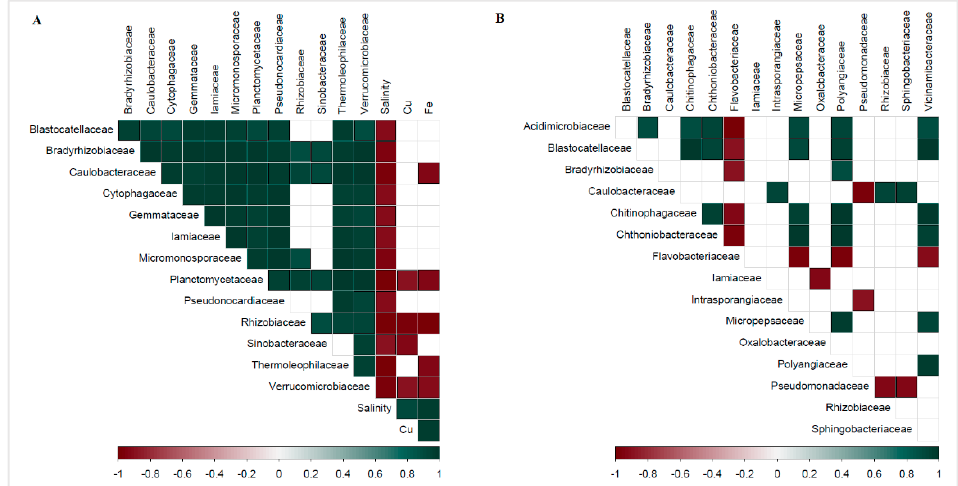
Figure 5. ( A )—Correlogram of rhizospheric family-rank sequence abundance data and soil chemistry. Only significant ( p < 0.05) correlations are shown. ( B )—Correlogram of root endosphere family-rank sequence abundance data. Only significant ( p < 0.05) correlations are shown; the color scale represents correlation coefficient values: dark green—positive correlation, dark red—negative correlation.